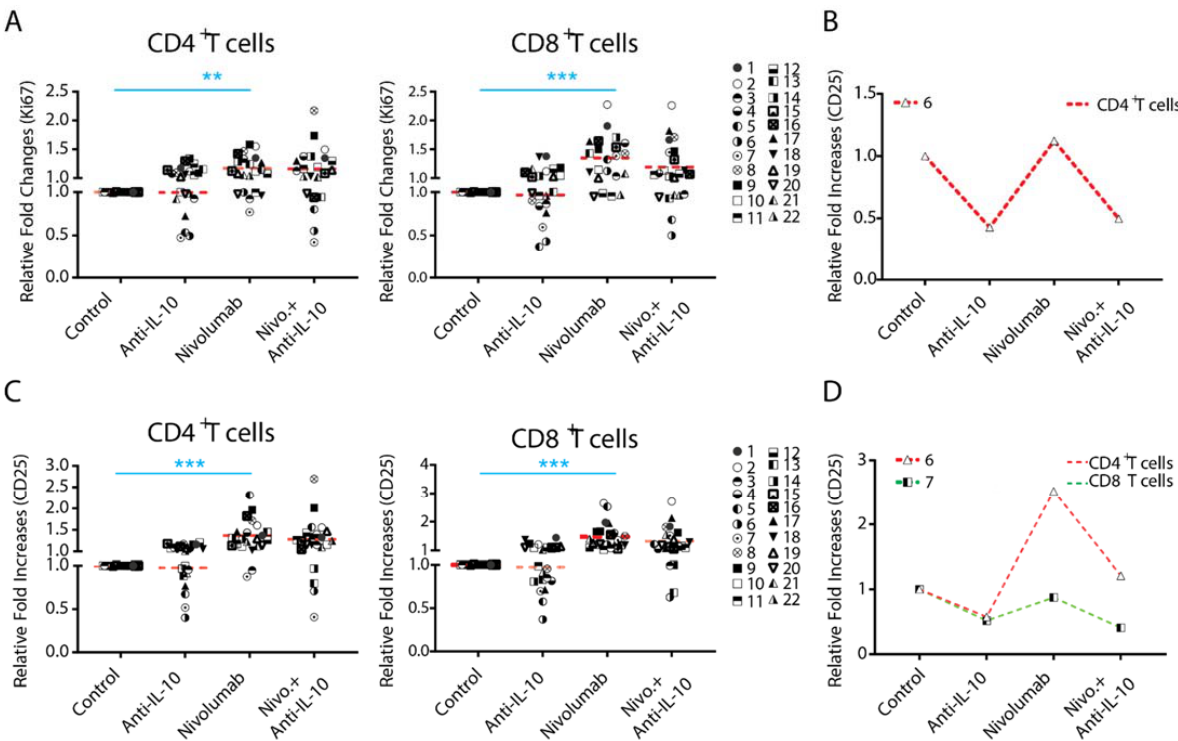
Figure 3. Anti ‐ interleukin ‐ 10 (anti ‐ IL ‐ 10) mAb induces heterogeneous expression of nuclear protein Ki67 (Ki67) and CD25 on CD4 + and CD8 + T cells. Purified T cells were co ‐ cultured with allogeneic monocyte ‐ derived dendritic cells in the presence of nivolumab (20 μ g/mL) with or without anti ‐ IL ‐ 10 mAb (5 μ g/mL) for 5 days, after which cells were harvested for flow cytometry analysis of Ki67 expression. ( A , B ) Donor pairs showing that anti ‐ IL ‐ 10 mAb decreased nivolumab ‐ modulated expression of Ki67 in CD4 + and CD8 + T cells are shown ( A ). Donor pairs with two ‐ fold changes between nivolumab and nivolumab plus anti ‐ IL10 mAb treatment are shown ( B ). ( C , D ) Purified T cells were co ‐ cultured with allogeneic monocyte ‐ derived dendritic cells in the presence of nivolumab (20 μ g/mL) with or without anti ‐ IL ‐ 10 mAb (5 μ g/mL) for 5 days, after which cells were harvested for flow cytometry analysis of CD25. Graphs show the relative fold change over the no ‐ antibody treatment controls ( C ). Donor pairs showing that anti ‐ IL ‐ 10 mAb decreased nivolumab ‐ modulated expression of CD25 in CD4 + and CD8 + T cells are shown ( D ). Each symbol represents data from one individual donor pair. Student’s t ‐ test, ** p < 0.01.*** p < 0.001.